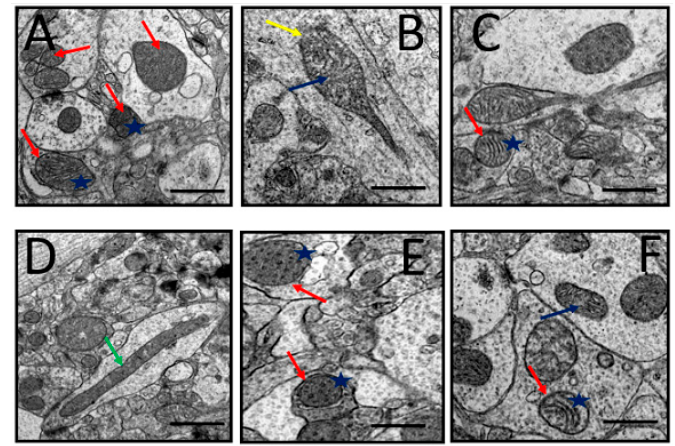
Figure 6. Representative TEM images depicting rat’s prefrontal cortex showing neuronal mitochondrial abnormalities after exposure to D-gal and AlCl 3 and those co-administered with donepezil and CA. ( A ) Control group: Normal mitochondrion (red arrow) with homogenous dense matrix, organized cristae (blue star), and double mitochondrial membrane. ( B ) Model group: Showed degenerated cristae (blue arrow) and ruptured mitochondrial membrane (yellow arrow). ( C ) Donepezil group: Showed normal and abnormal mitochondria. ( D ) CA 200 group: Showed elongated mitochondria (green arrow). ( E , F ) CA 400 and CA 800 groups, respectively: Showed normal mitochondria (red arrows) and well-organized cristae (blue star). Scale bar 0.5 µm.